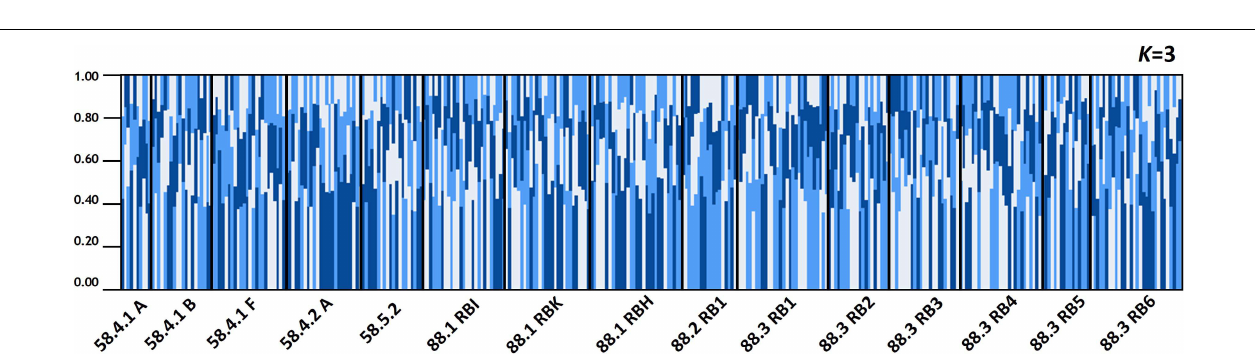
FIGURE 5 | Population structure based on a Bayesian population assignment assuming of Dissostichus mawsoni for 15 populations from Subareas 58 and 88 in the Antarctic Ocean using seven microsatellite loci. Each individual is represented along the X -axis, and the Y -axis denotes the probability of that individual belonging to each of the genetic clusters. Analyses of population structure for the all 15 populations combined. The mixing of genetic units is apparent most likely due to high population connectivity.